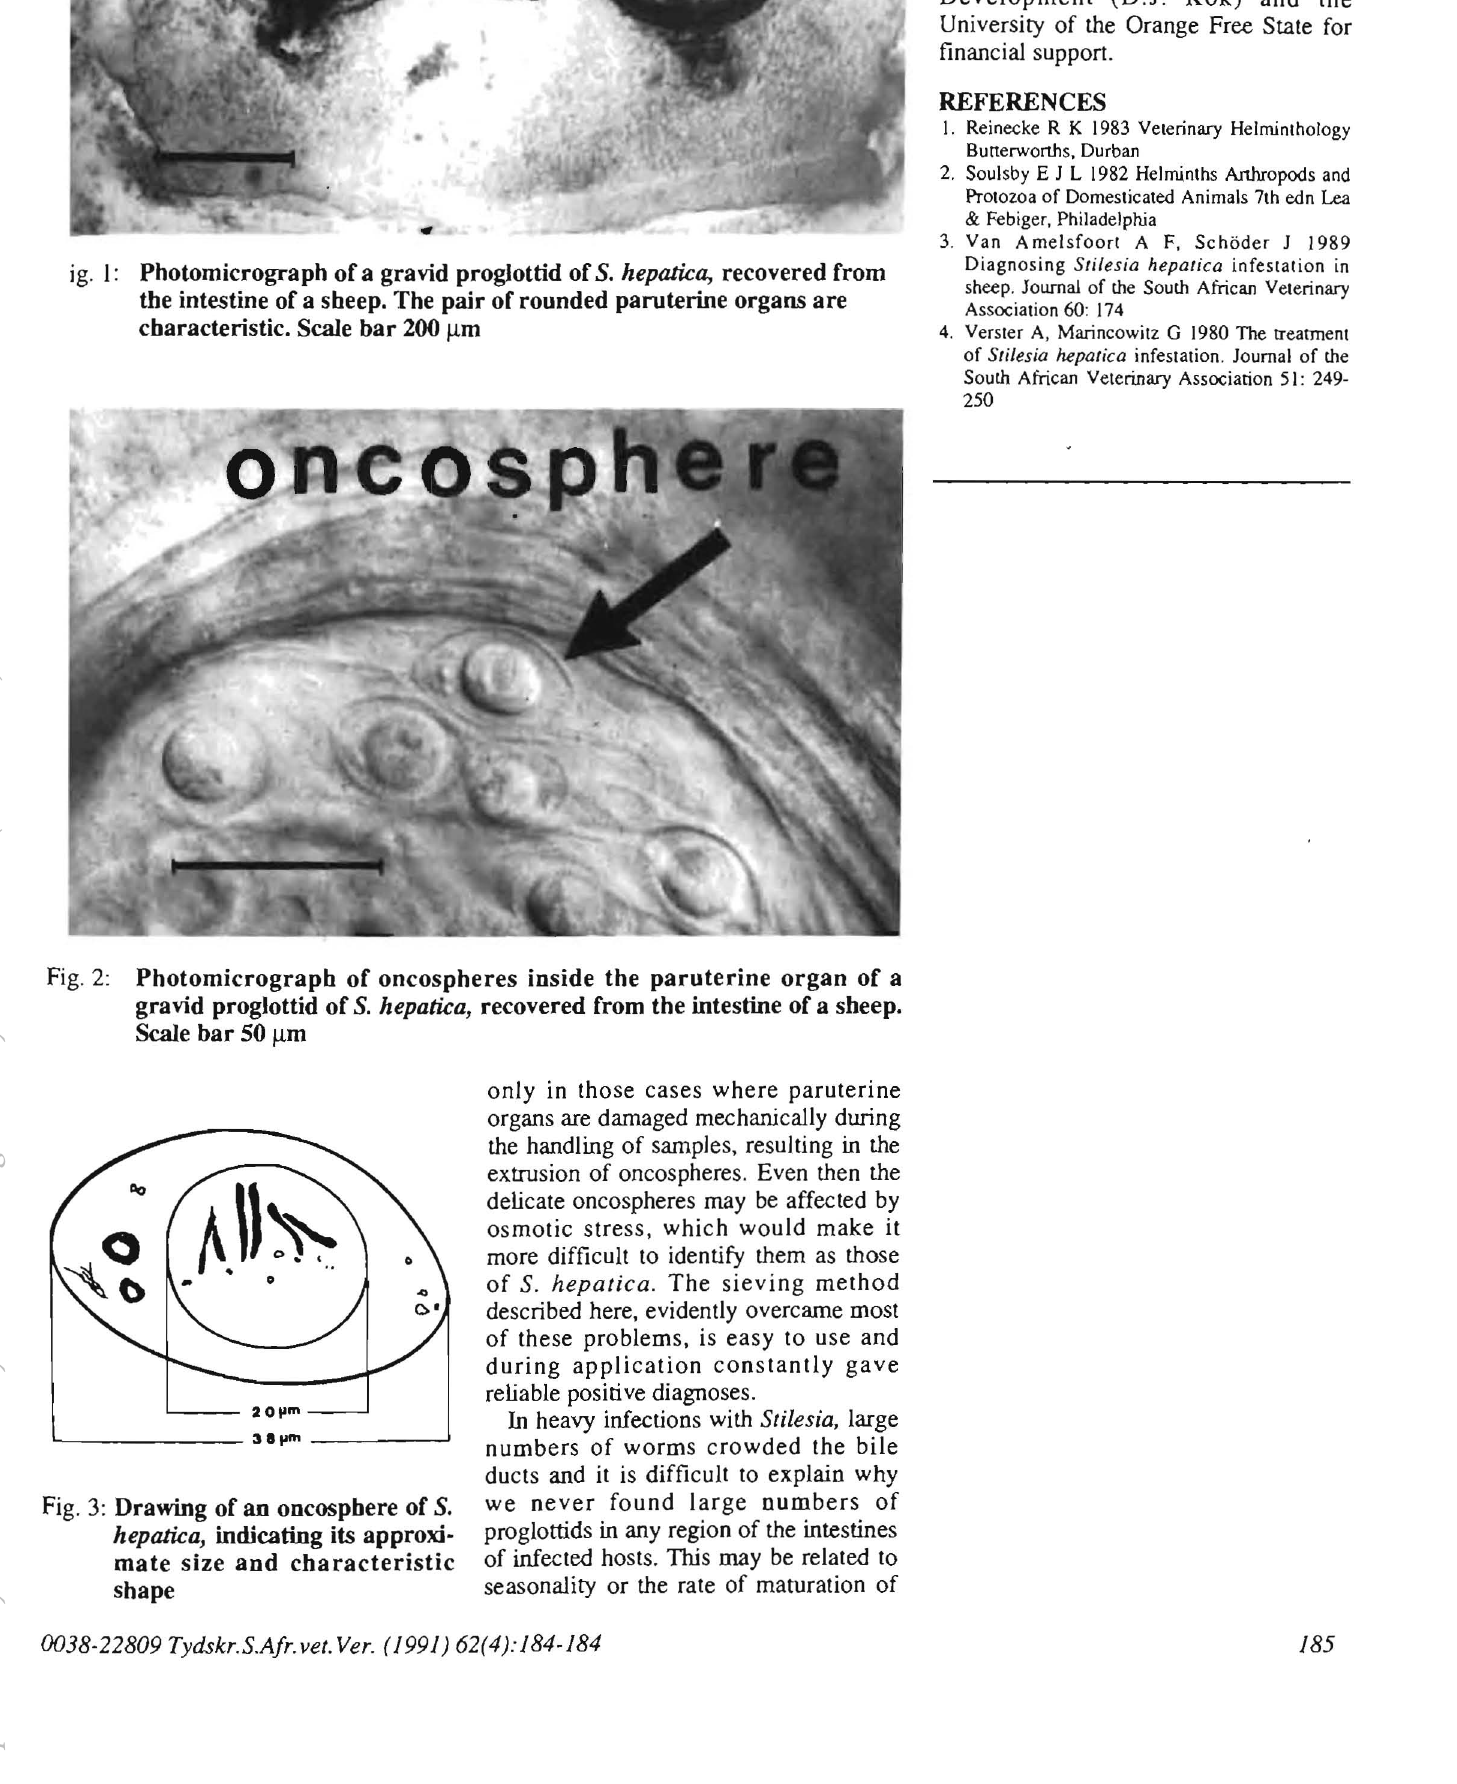
Fig. 3: Drawing of an oncospbere of S. hepatica, indicating its approxi mate size and characteristic